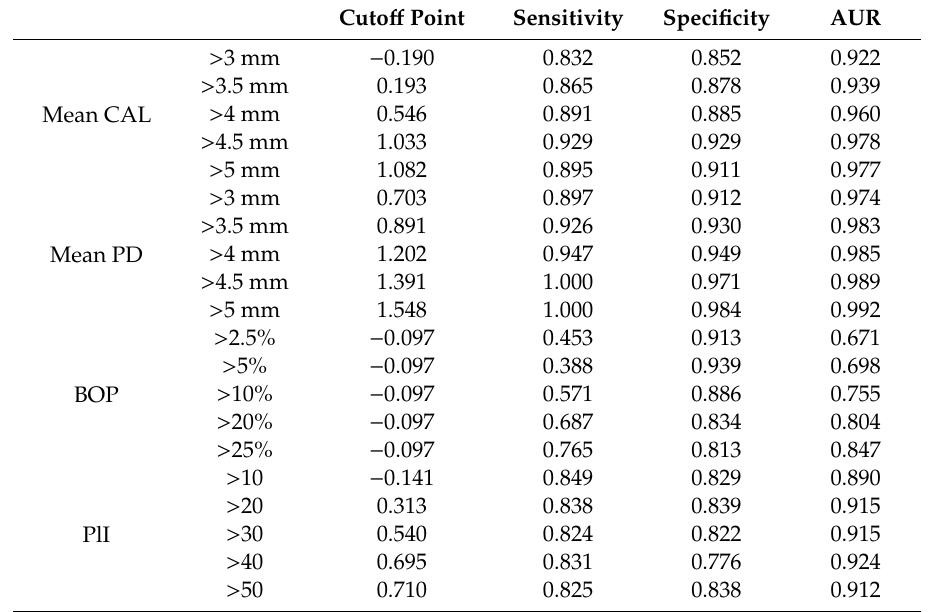
Table 2. Sensitivity, specificity, and area under the receiver operating characteristic curve for the six